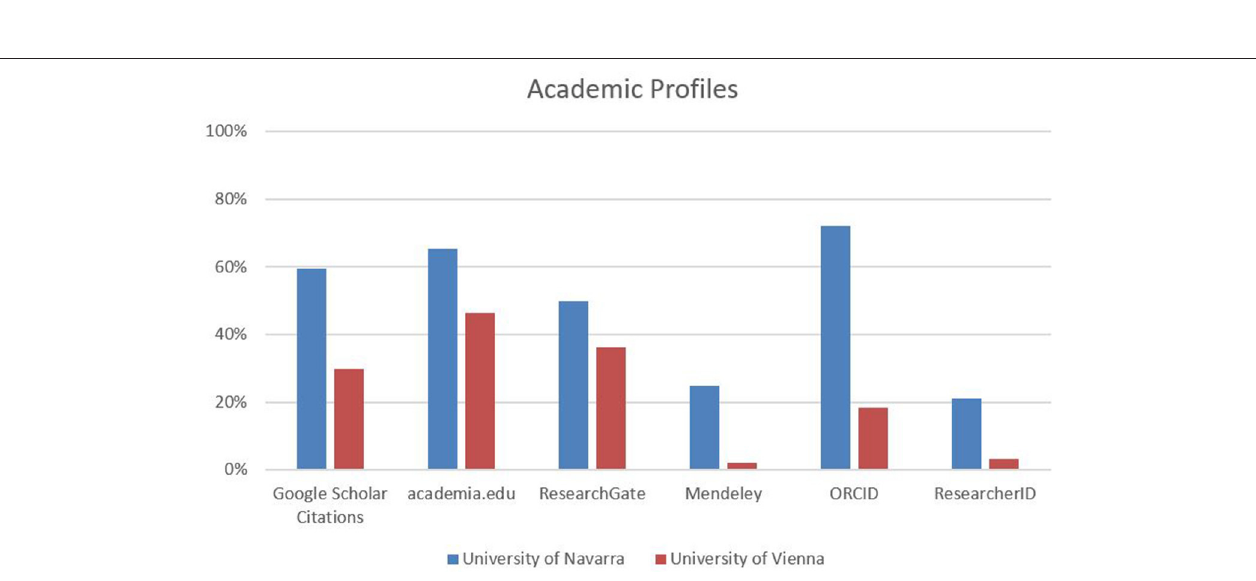
FIGURE 8 | Academic